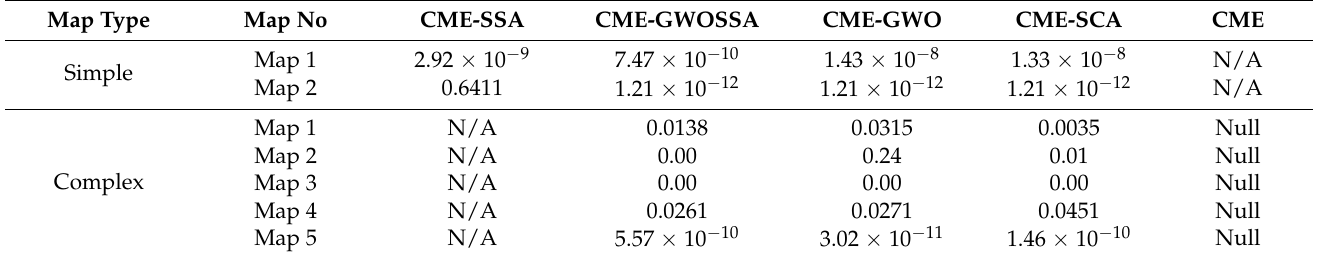
Table 5. p − values for the exploration results in Tables 1 and 4 as calculated by the Wilcoxon rank − sum test (N/A stands for not applicable, Null no